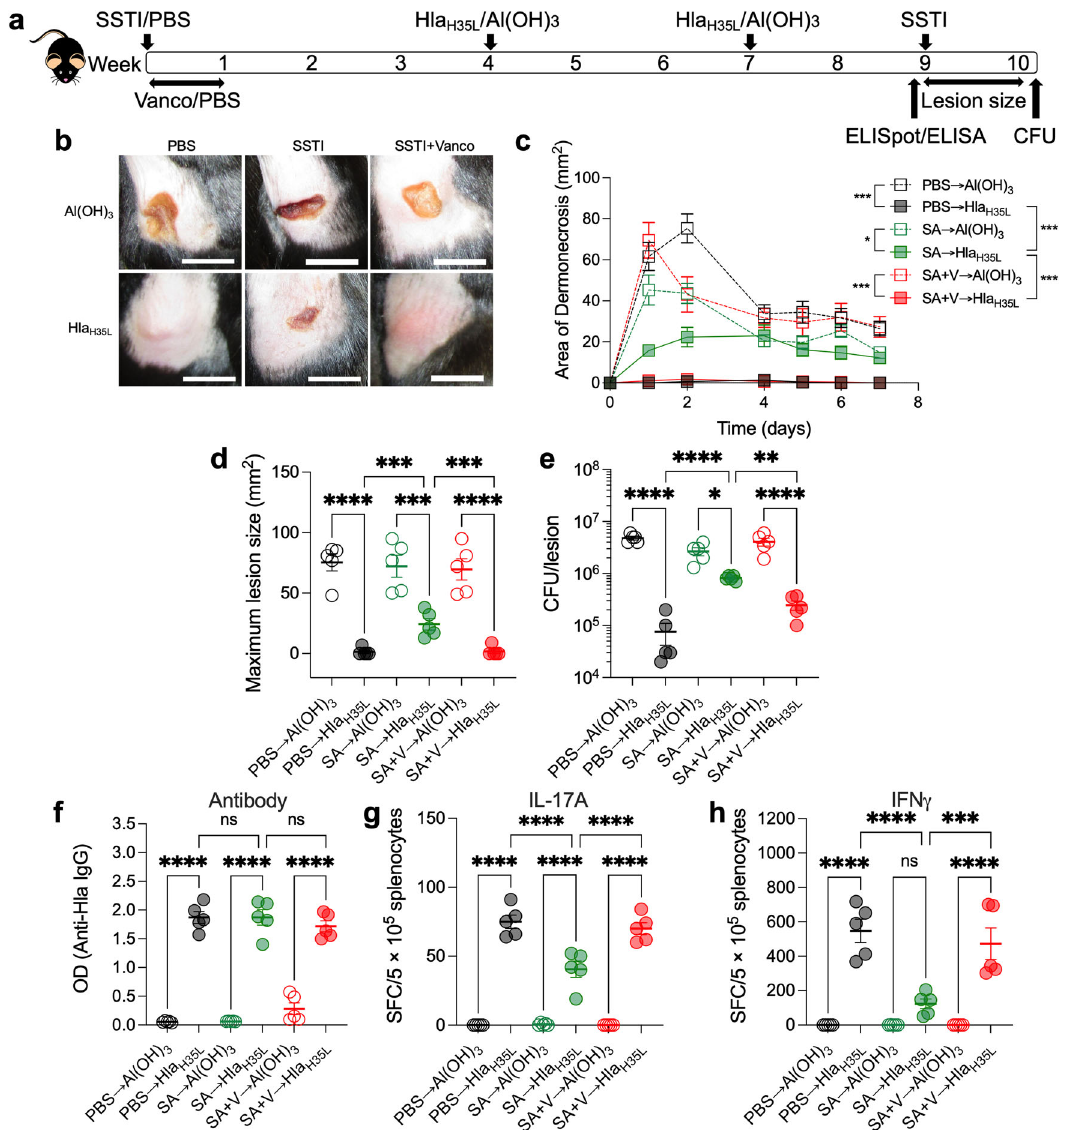
Fig. 3 Bacterial persistence during primary SSTI is necessary for impairment of Hla H35L vaccine ef fi cacy and T cell responses. a Experimental model: mice were infected with S. aureus (SA) SSTI followed by vaccination with Hla H35L and secondary SSTI or quanti fi cation of Hla-speci fi c IgG levels and T cell responses. Selected groups were treated with vancomycin during primary SSTI. b Representative lesions on day 2. Scale bar = 10 mm. b – d Protection against secondary dermonecrosis was rescued in mice that received vancomycin during primary SSTI (SA + V → Hla H35L ), compared with untreated vaccinated mice (SA → Hla H35L ). e Enhanced bacterial clearance in the SA + V → Hla H35L group, compared with the SA → Hla H35L group. f Vancomycin treatment did not impact vaccine-elicited Hla-speci fi c IgG levels. g , h Vancomycin treatment rescued Hla-speci fi c IL-17A ( g ) and IFN γ ( h ) responses following vaccination; there were more IL-17A and IFN γ staining cells in the SA + V → Hla H35L group, compared with the SA → Hla H35L group. N = 5 mice/group; one representative experiment of two repeats is presented. Data are presented as mean ± SEM and were analyzed using two-way ANOVA with repeated measures and Tukey ’ s post- test ( c ) or one-way ANOVA with Tukey ’ s post-test ( d – h ). CFU data were log 10 transformed for analysis.* indicates p < 0.05; ** p <